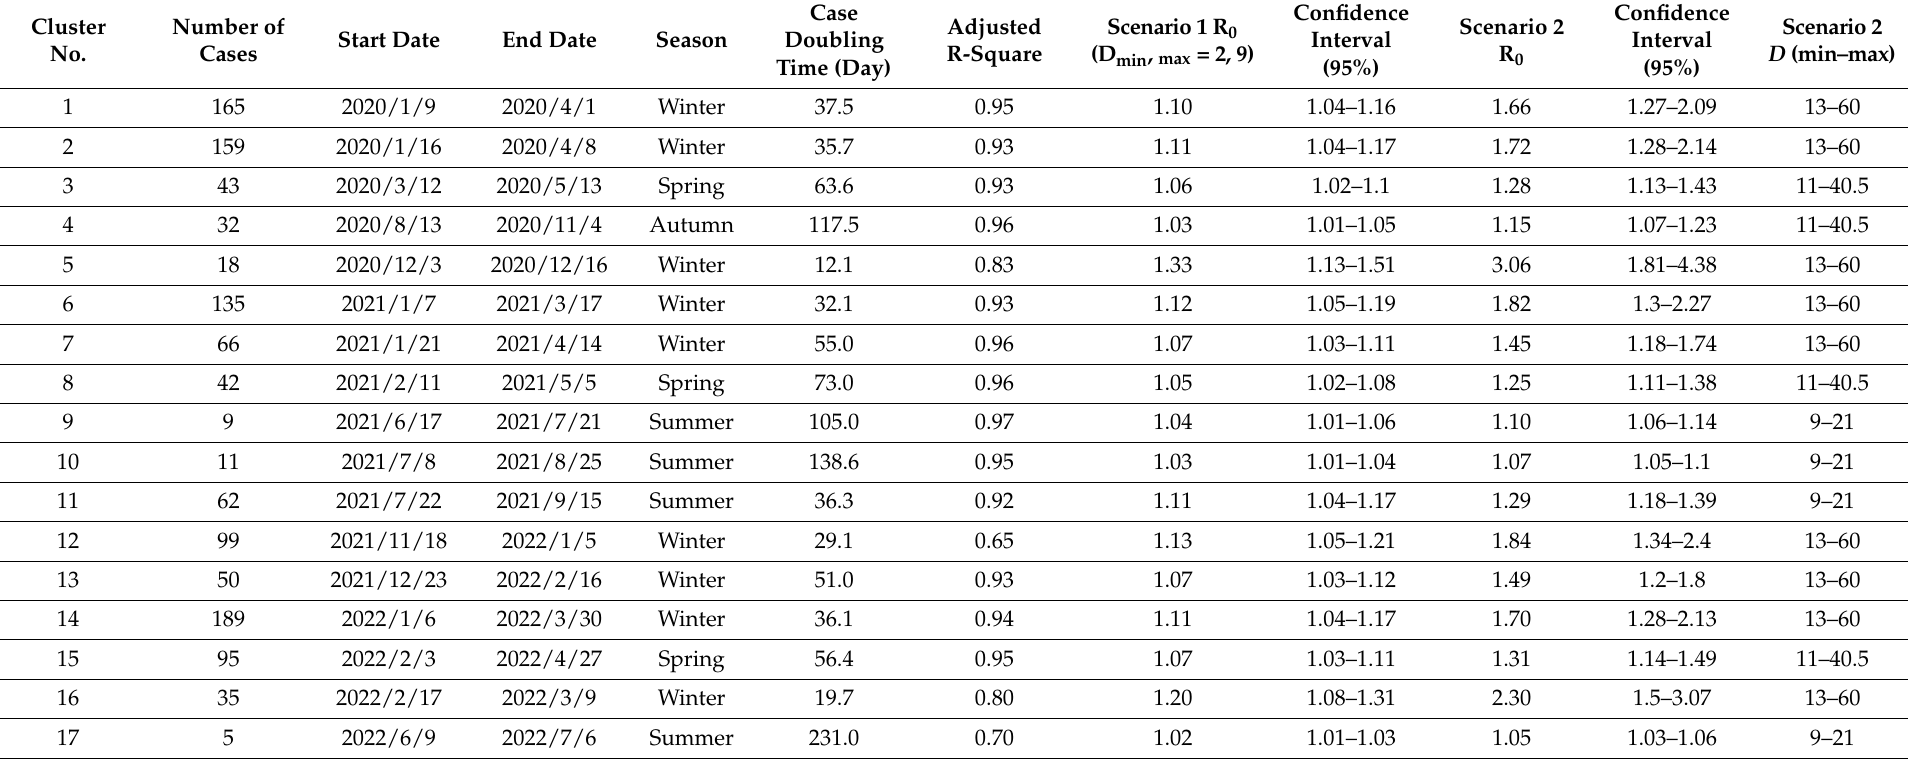
Table 1. Detailed information regarding each spatio-temporal cluster and R 0 . Scenario 1 considers direct transmission between wild boar, while Scenario 2 includes indirect transmission via infected carcasses. The season containing more days was